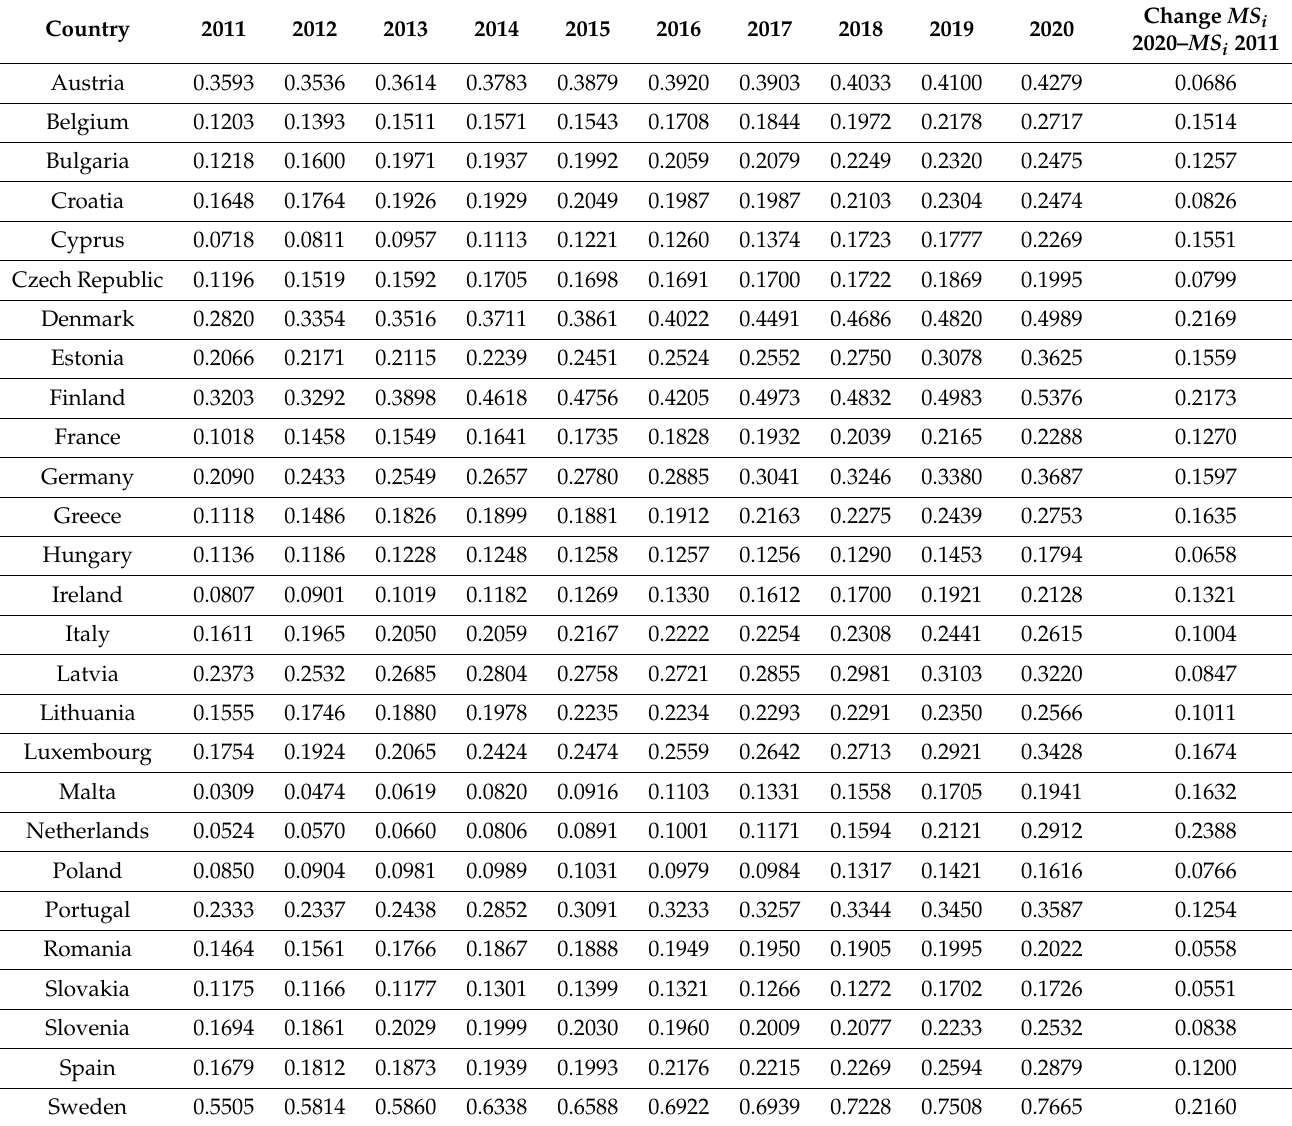
Table 4. Values of the synthetic measure in the level of renewable energy use for EU countries